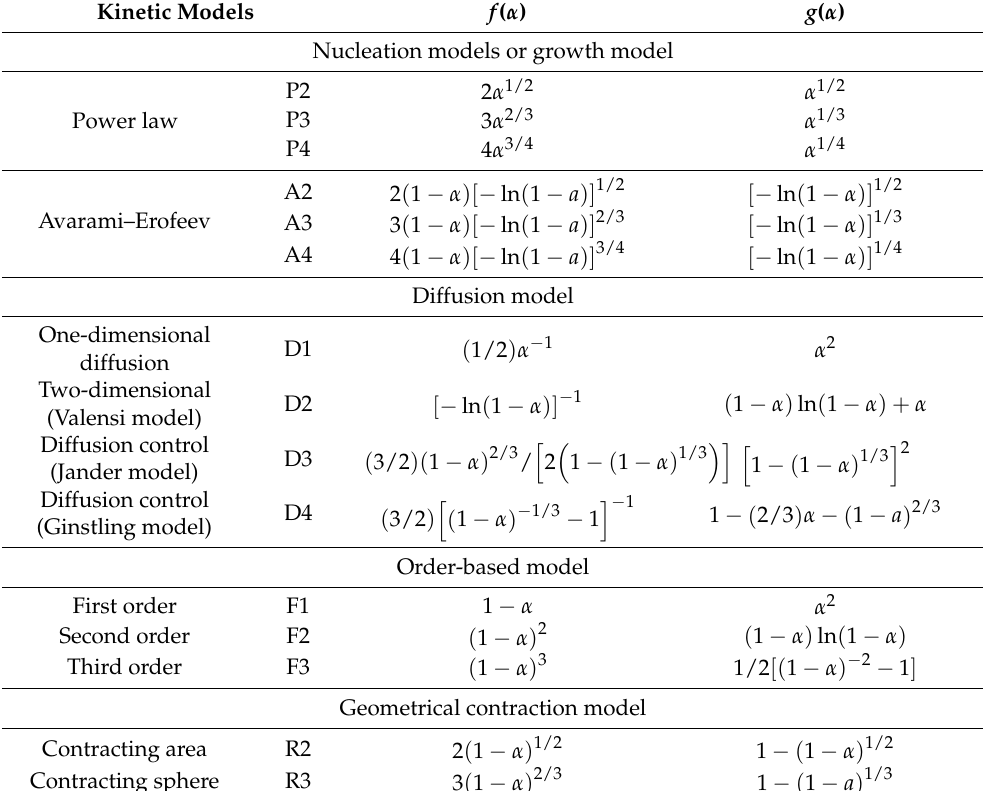
Table 1. Various theoretical kinetic reaction models [ f ( α ) ] and their integral expression [ g ( α )] of solid pyrolysis process. Kinetic